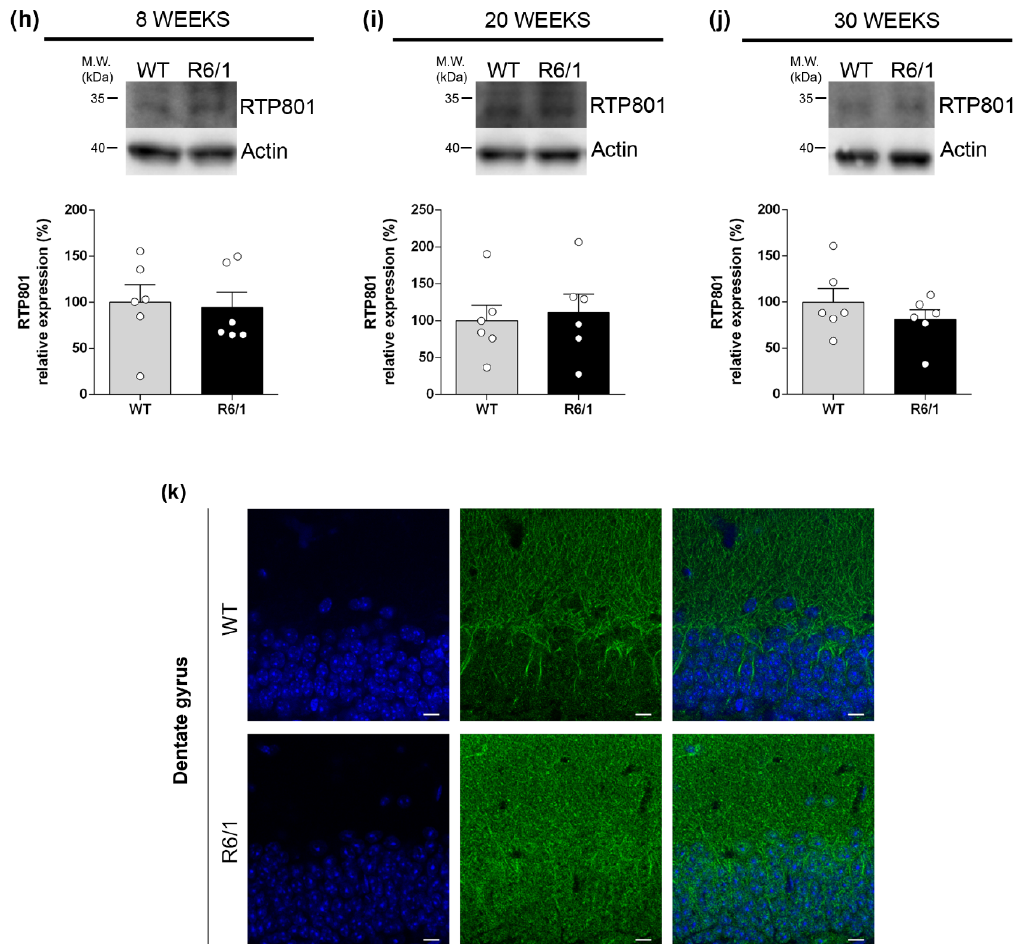
Figure 1. RTP801 levels are increased in the hippocampus of HD patients and correlate with neuroinflammatory markers but are not altered in the R6/1 mouse. ( a ) Immunoblotting for RTP801, GFAP, Iba1, and actin as loading control in total homogenates from human post-mortem hippocampal samples from non-affected individuals (CT) and Huntington’s disease (HD) patients. Densitometric quantifications of RTP801 ( b ), astrogliosis marker GFAP ( d ), and microgliosis marker Iba1 ( f ). Pearson’s correlation analysis comparing RTP801 levels as in ( b ) with Vonsattel grades ( c ), GFAP levels ( e ), and with Iba1 levels ( g ) per sample. ( h – j ) Immunoblotting for RTP801 and actin as loading control in total homogenates from 8, 20, and 30 weeks old wild-type (WT) and R6/1 mice. ( i ) Densitometric quantification of RTP801 protein levels. Data in ( b,d,f,i ) is represented as mean ± SEM and was analyzed with Student’s t -test. * p < 0.05, *** p < 0.001 vs. CT. ( k ) RTP801 immunostaining in 8-week-old WT and R6/1 mouse hippocampus (dentate gyrus). Coronal sections were stained with an antibody against RTP801 (in green) and nuclei were visualized with Hoechst 33352 staining (in blue). Scale bars, 10 µm.